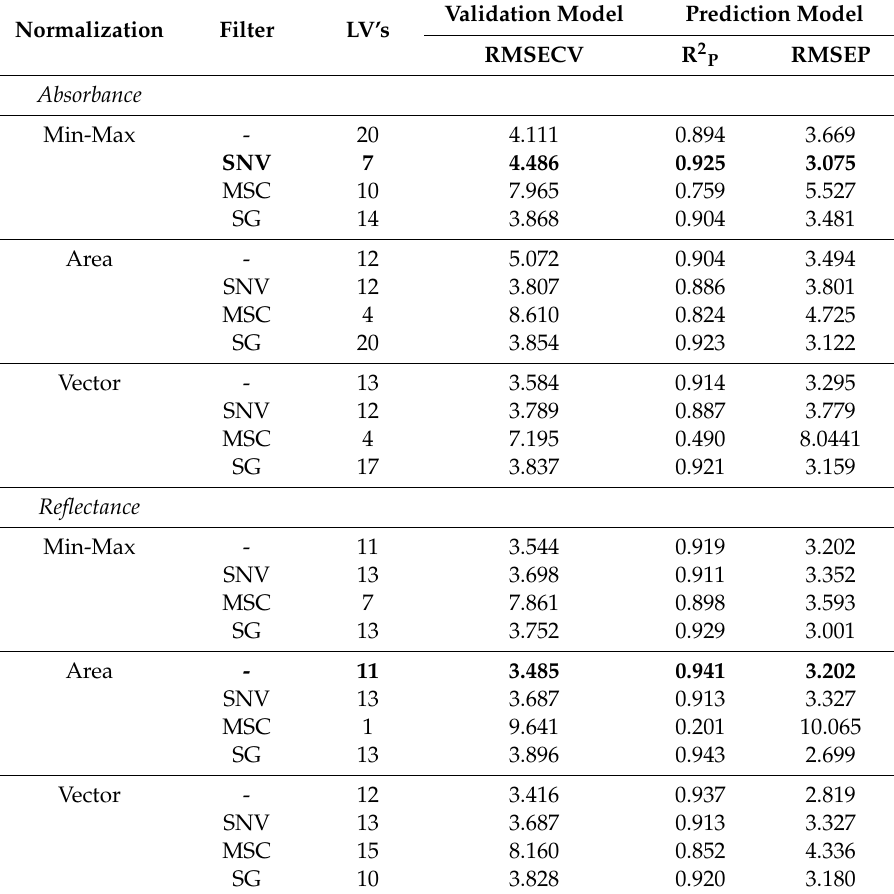
Table 4. Performance of PLSR for prediction TWC based on 37 wavelengths.